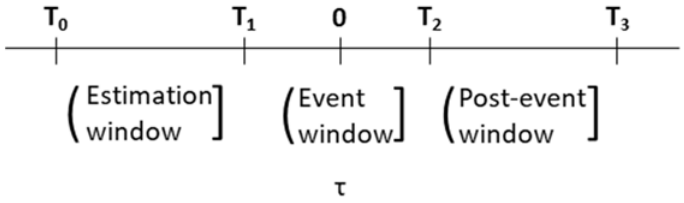
Figure 2. Event study framework timeline.